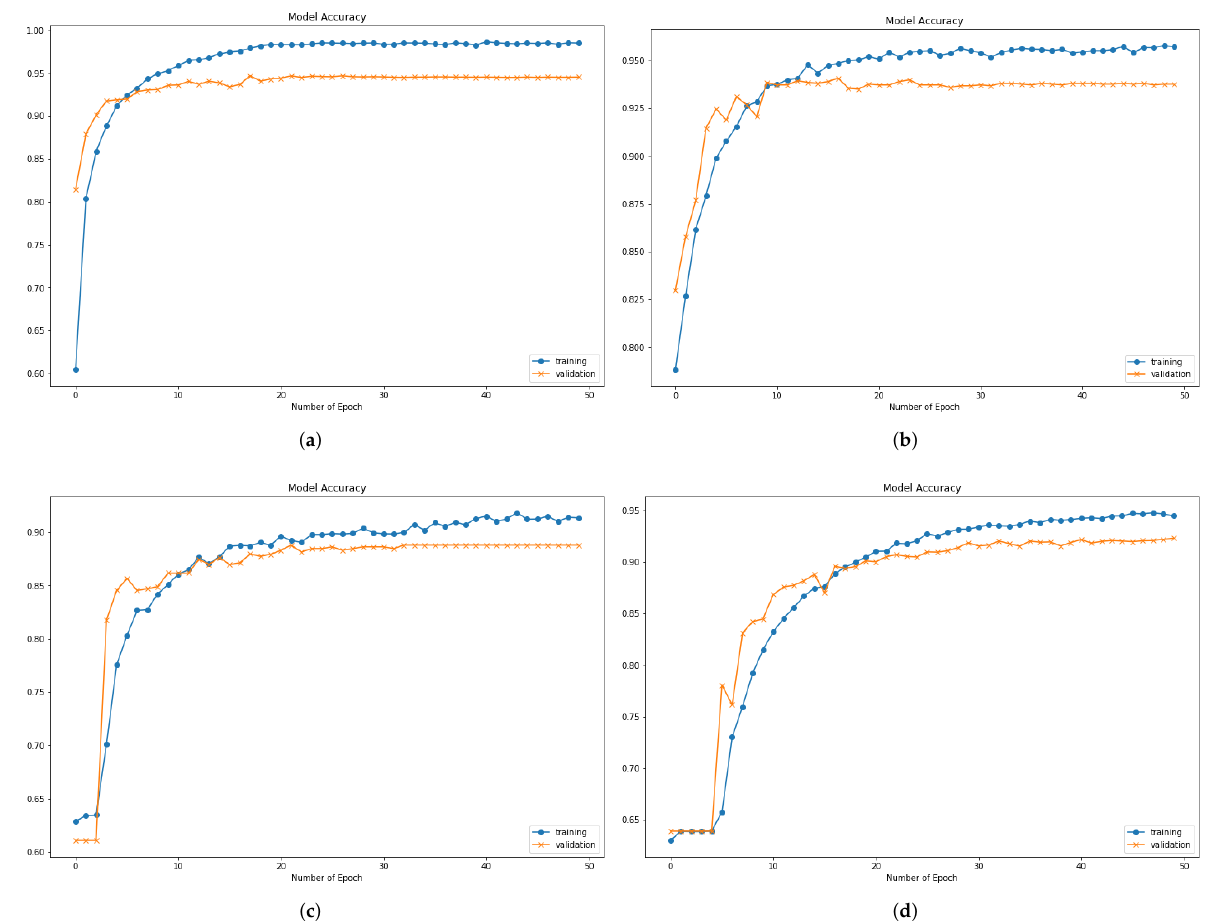
Figure 3. Performance comparison obtained by different methods on the SD4A dataset ( a ) ; US-Airline dataset ( b ) ; Sentiment140 dataset ( c ) ; Sentiment140-MV dataset ( d )